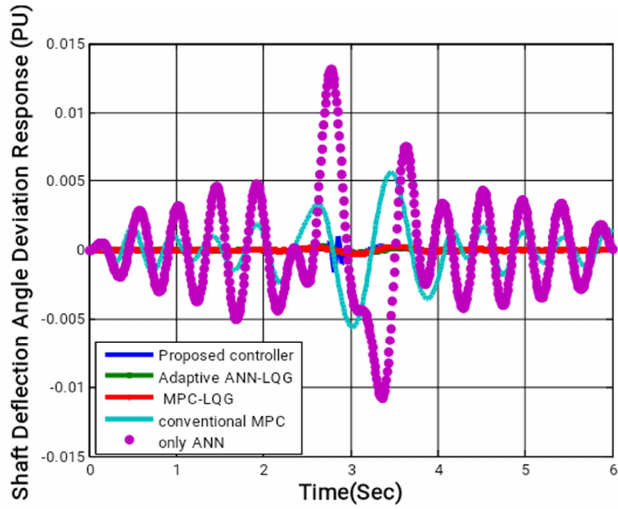
Figure 10. Shaft deflection angle response.